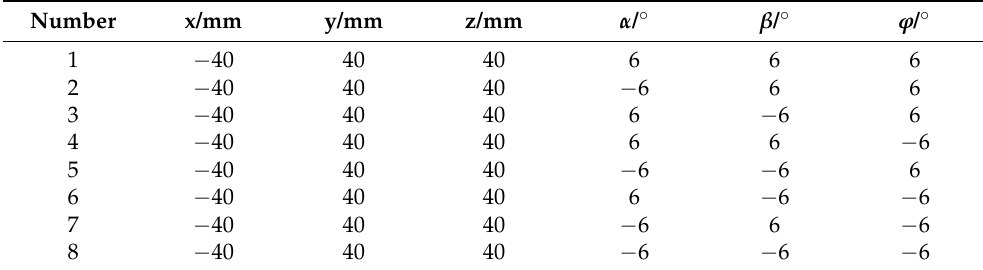
Table 1. Summarized key positional posture